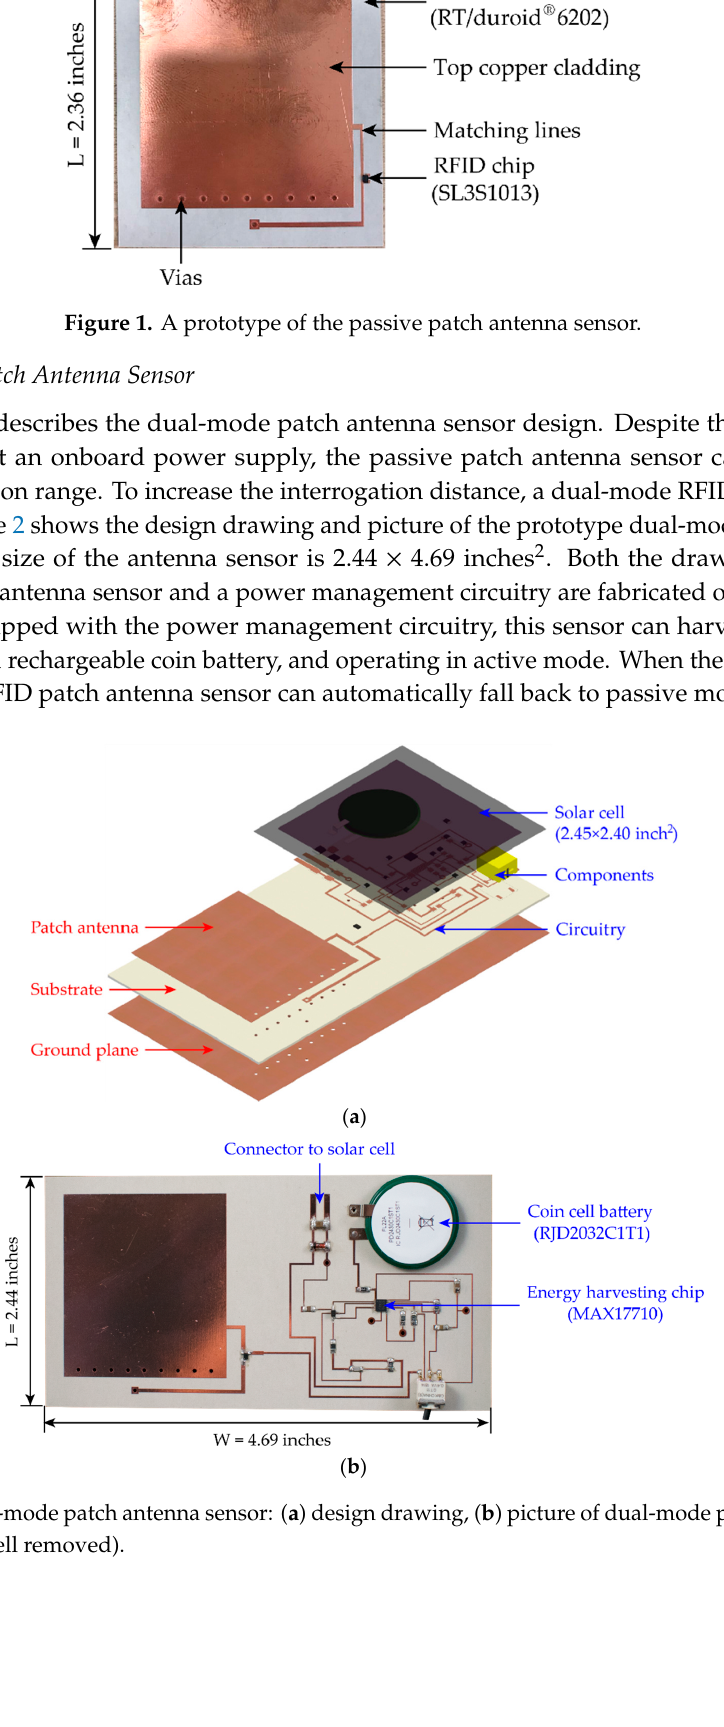
Figure 1. A prototype of the passive patch antenna sensor.